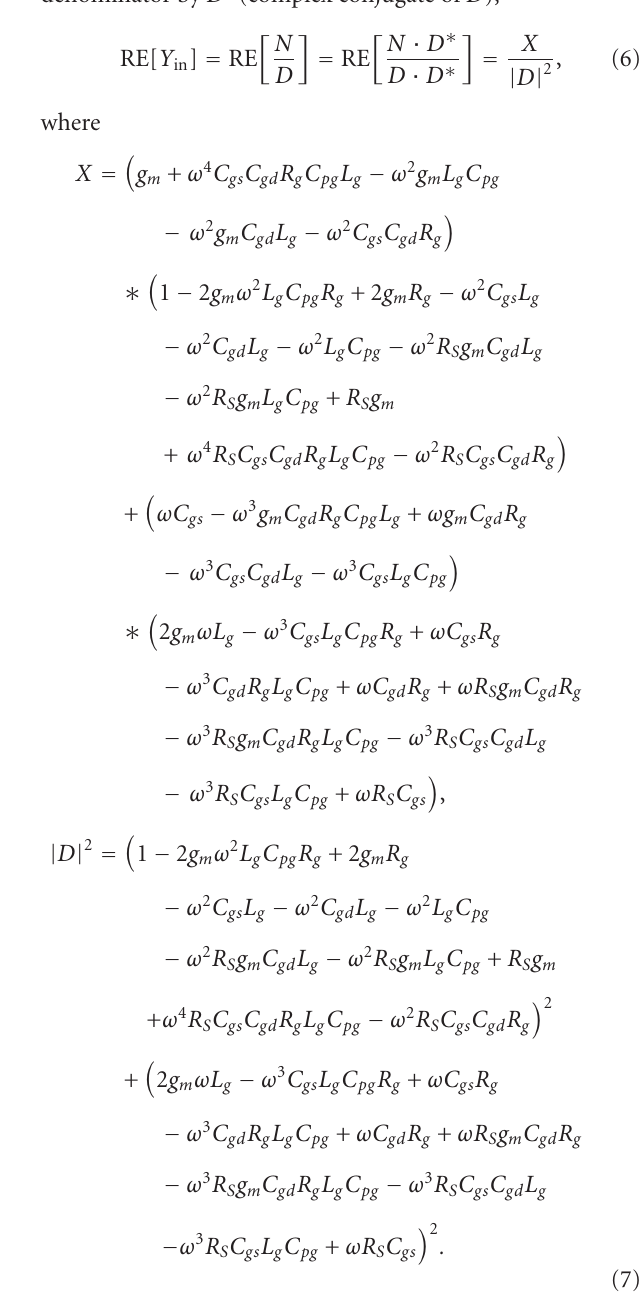
R n = 1 / RE[ Y in ] is then computed for various circuit param-